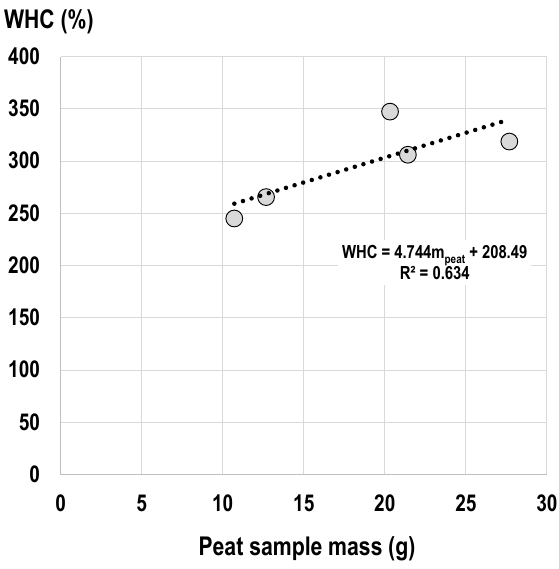
Figure 2. Interrelationship between the WHC of peat according to the ‘droplet counting method’ (CEN/TS 15083-2, 2005) and the mass of the peat sample.